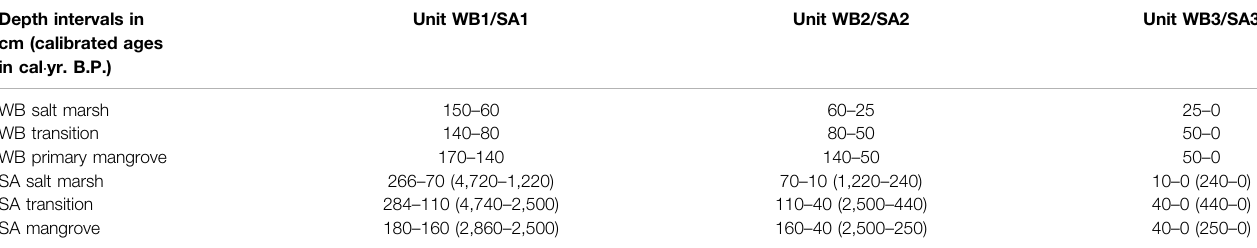
( Supplementary Table S1 ). Within St. Augustine cores, the transition SA3 is signi fi cantly higher in TOC compared to all other St. Augustine units. Individual SA3 units are all signi fi cantly higher in TOC compared to their respective SA2 and SA1 units.